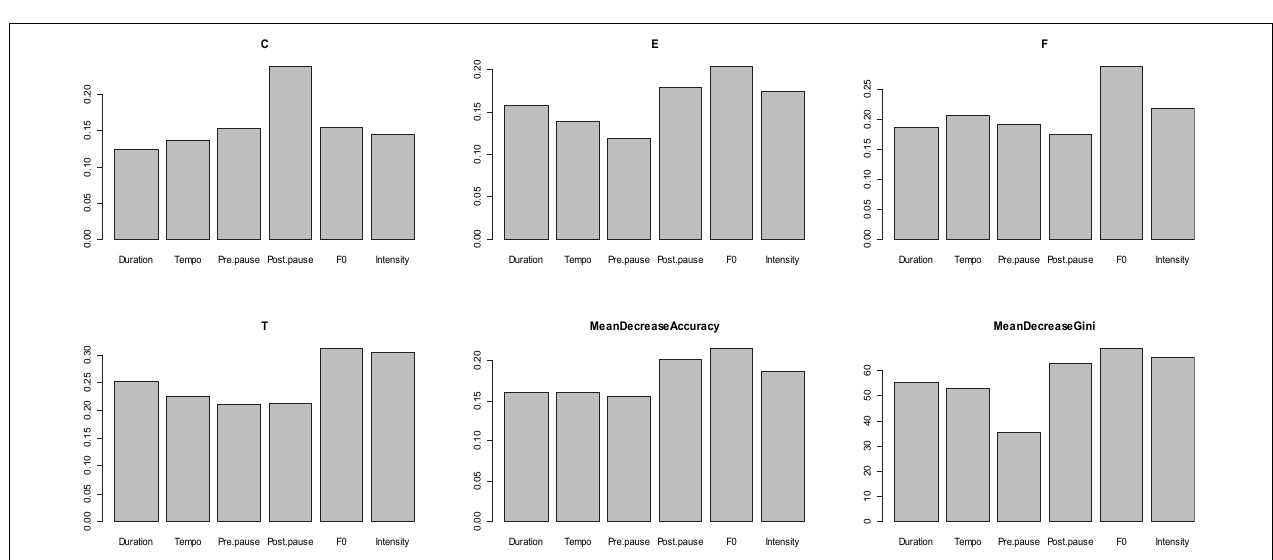
FIGURE 12 | Random forest pragmatics classification model of ni zhidao based on its prosody. In this model, “C,” “E,” “F,” and “T” refers to the pragmatic functions of “coherence-marking,” “emotion-projecting,” “floor-holding,” and “topic-initiating” respectively.